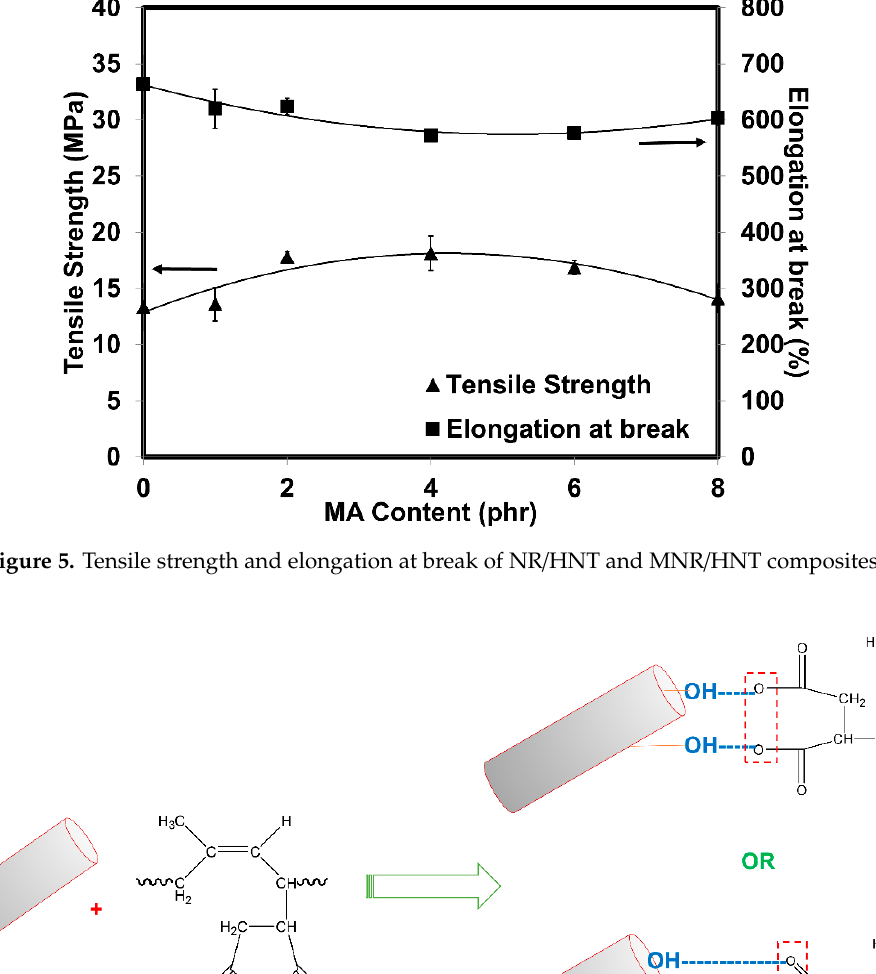
Figure 4. Stress–strain curves of the NR/HNT and MNR/HNT composites.